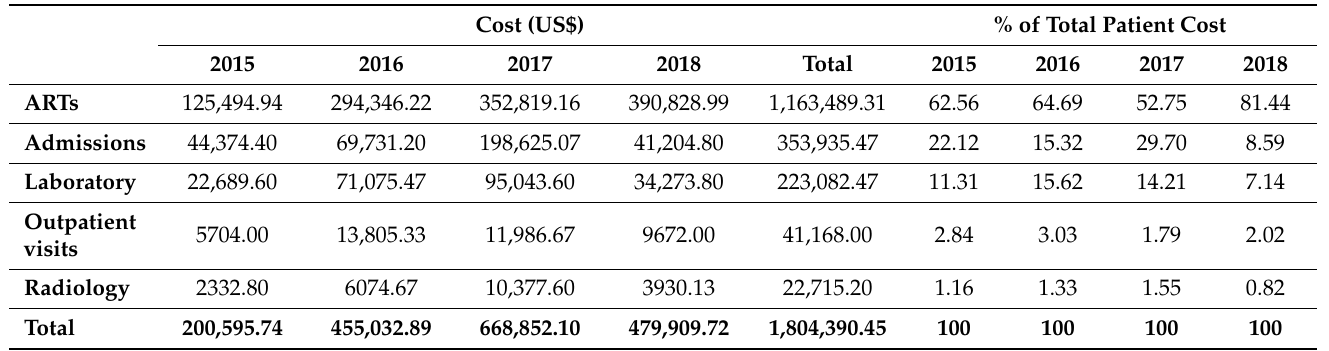
Table 3. Total cost and percentage impact per year of the cost categories from 2015 to 2018. Cost (US$)